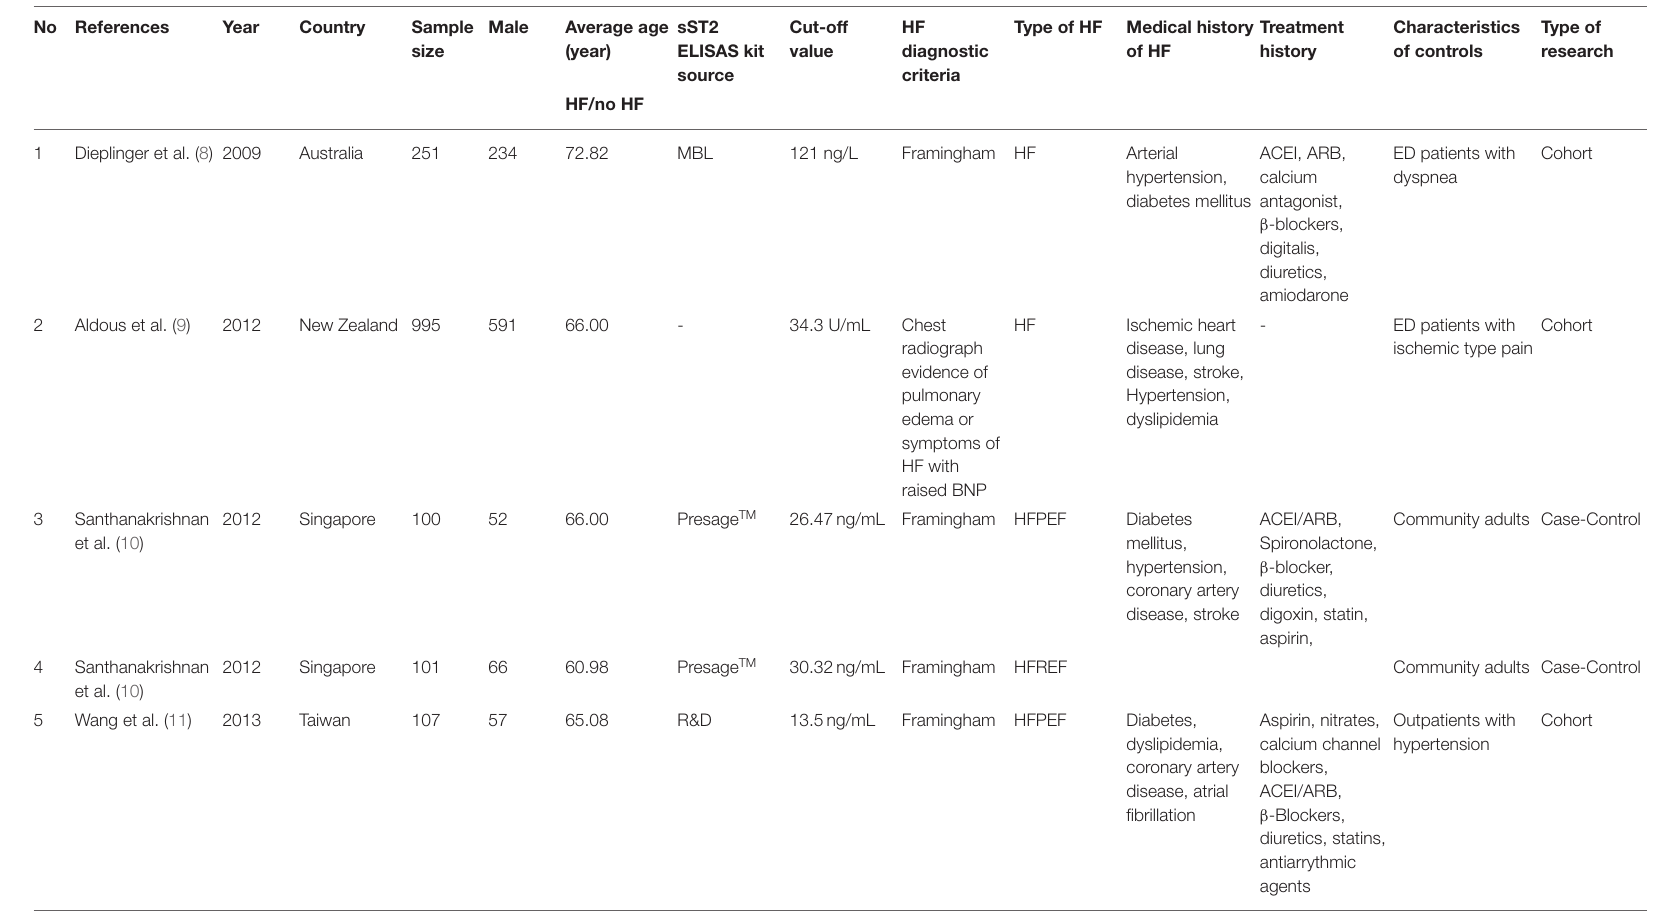
TABLE 1 | Characteristics of the studies included in this